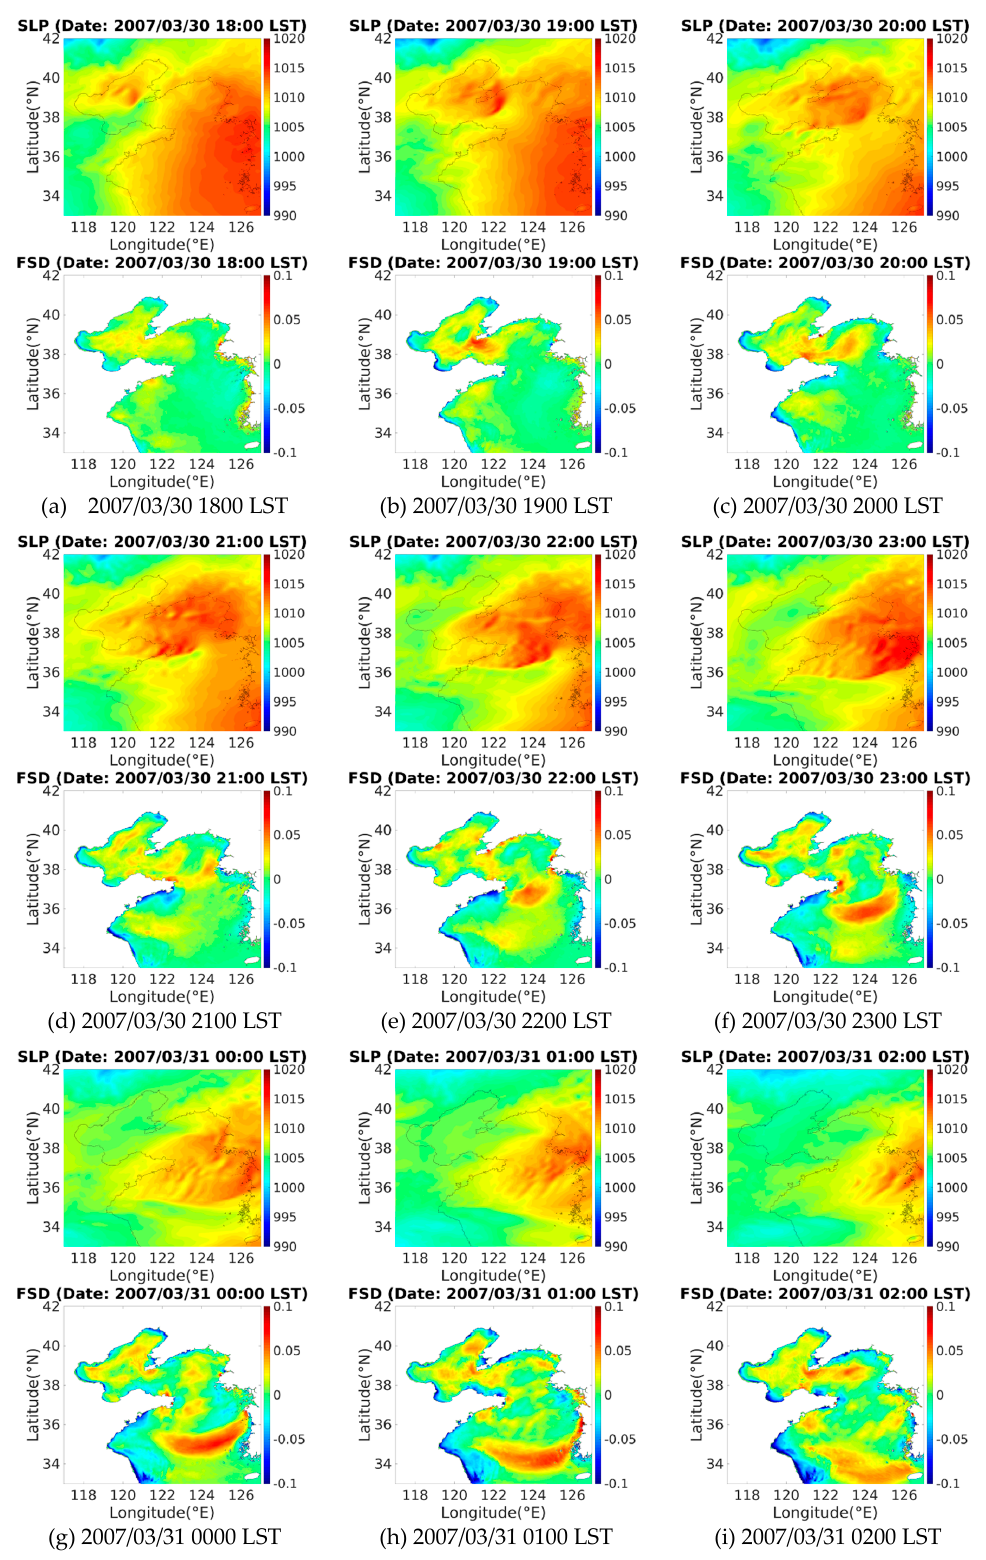
Figure 7. The free surface displacement (FSD, bottom) and sea level pressure (SLP, above) change in the Yellow Sea during the meteotsunami that occurred in March 2007. ( a ) 1800 LST 30 Mar 2007; ( b ) 1900 LST 30 Mar 2007; ( c ) 2000 LST 30 Mar 2007; ( d ) 2100 LST 30 Mar 2007; ( e ) 2200 LST 30 Mar 2007; ( f ) 2300 LST 30 Mar 2007; ( g ) 0000 LST 31 Mar 2007; ( h ) 0100 LST 31 Mar 2007; ( i ) 0200 LST 31 Mar